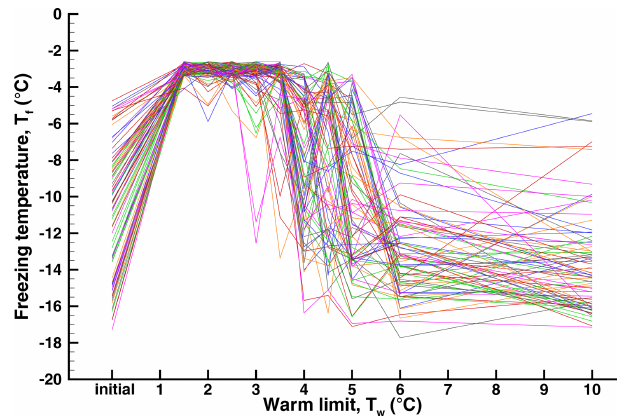
Figure 10. Histograms of the changes in freezing temperatures be- tween successive pairs of runs in Exp. A.